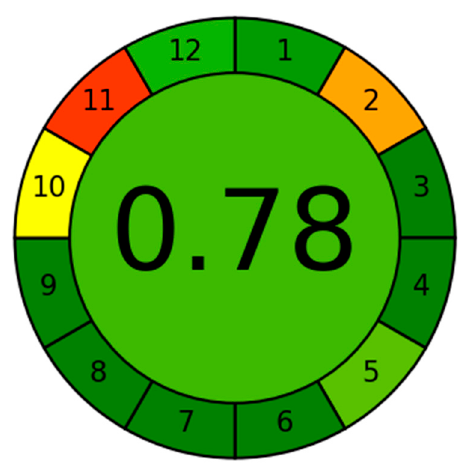
Figure 5. AGREE pictogram for the greenness assessment of the proposed method.